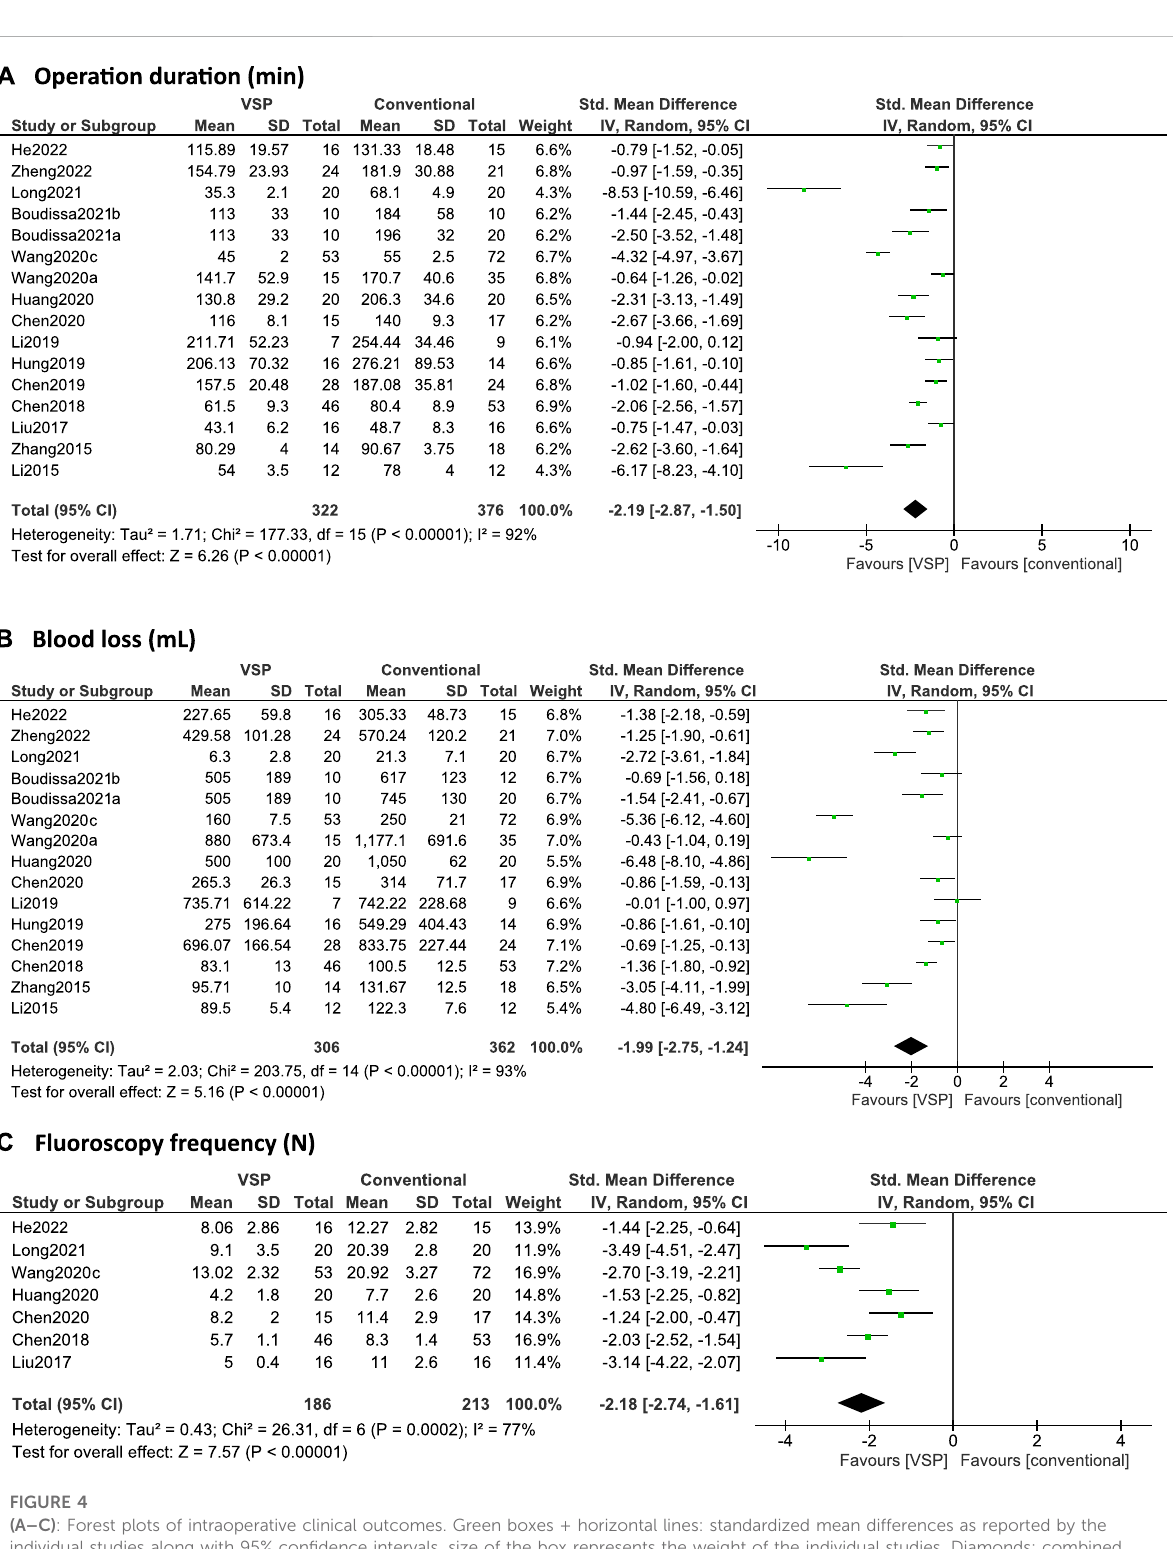
FIGURE 4 (A – C) : Forest plots of intraoperative clinical outcomes. Green boxes + horizontal lines: standardized mean differences as reported by the individual studies along with 95% con fi dence intervals, size of the box represents the weight of the individual studies. Diamonds: combined standardizedmeandifferencewiththeouteredgesrepresentingthe95%con fi denceinterval.Total:numberofpatients. (A) Operationduration(min), (B) Blood loss (ml), (C) Intra-operative fl uoroscopy frequency